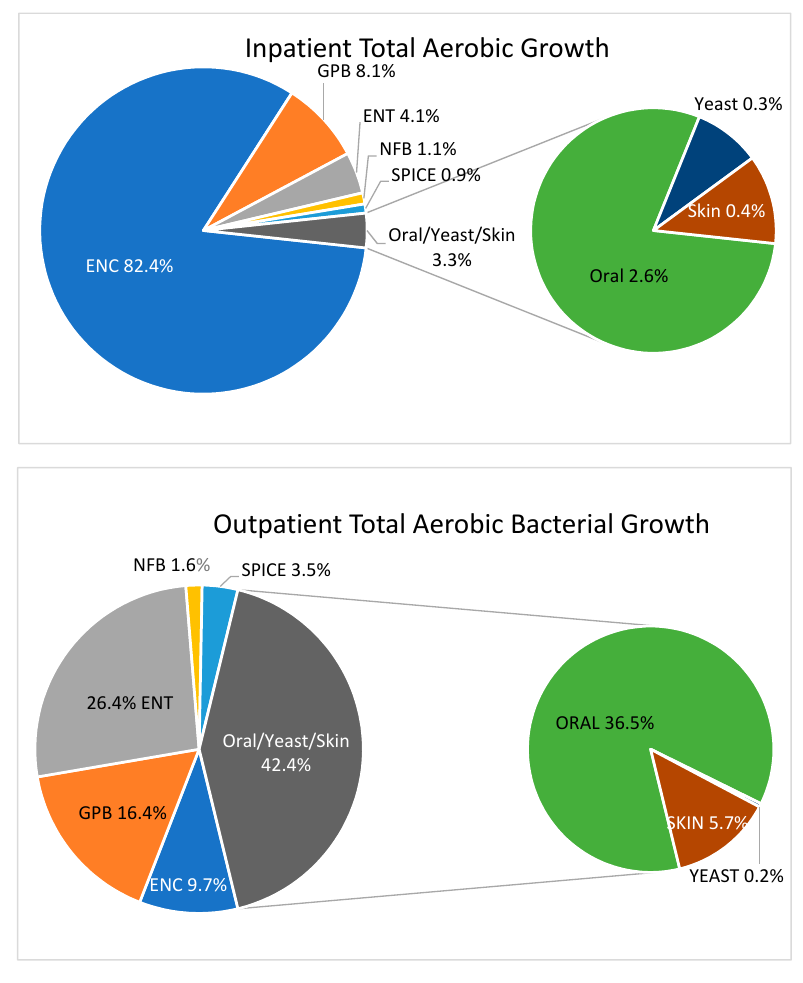
Figure 1. Percent total aerobic bacterial growth by bacterial category. Non-Fermenting Gram Negative Bacilli (NFB)— Pseudomonas aeruginosa , Acinetobacter spp., Chryseobacterium spp., Stenotrophomonas